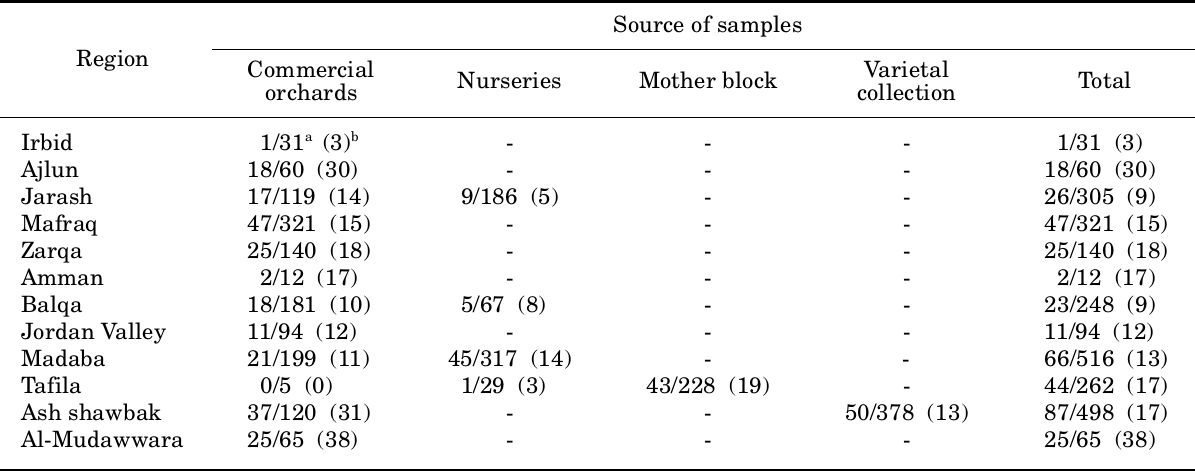
Table 2. Incidence of PNRSV in stone fruit trees/seedlings from different locations in Jordan: commercial orchards, nurseries, a mother block, and a varietal collection, irrespective of Prunus species, surveyed during 2000–2002 using DAS-ELISA.